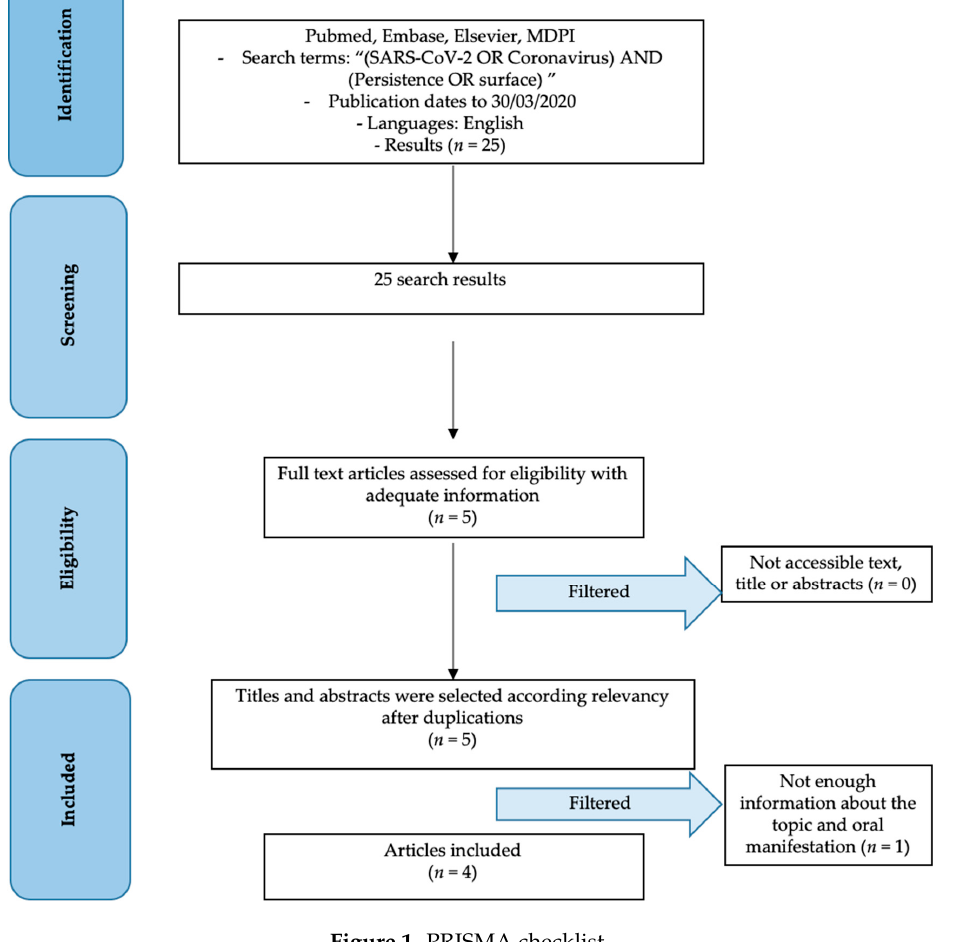
Figure 1. PRISMA checklist.